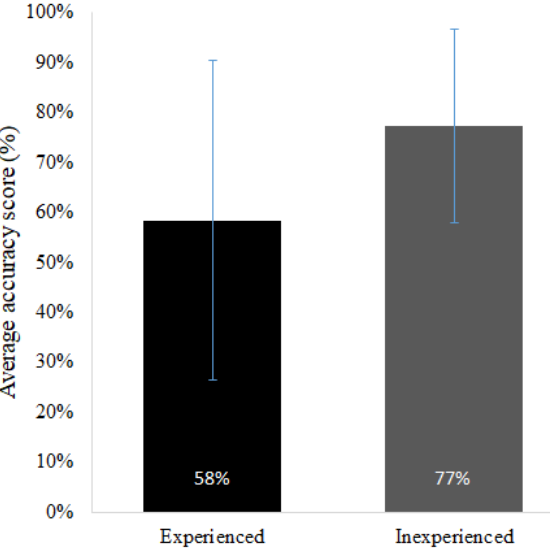
Figure 7. Average accuracy scores (in percentage) of the experienced (n=6) and inexperienced (n=81) participants for each level. Error bars: Figure 6. The average accuracy scores for each light direction for all participants. * p<.05.Note that here we only present the inferential statistics for the accuracy with NW (315 o ) against NNW (337.5 o ) and N (0 o ), because the other two light directions (270 o and 292.5 o ) clearly impair landform detection accuracy and are not desirable.